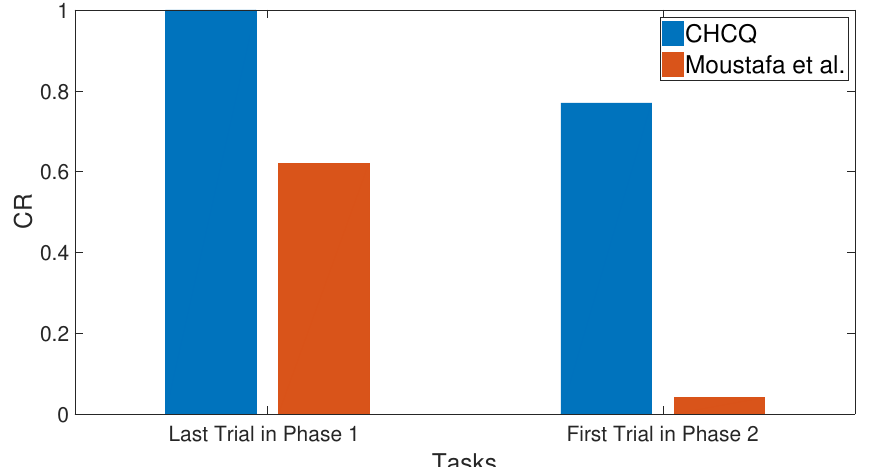
Figure 33. Context sensitivity task for the intact system of the last and first trial values of the two phases, respectively.